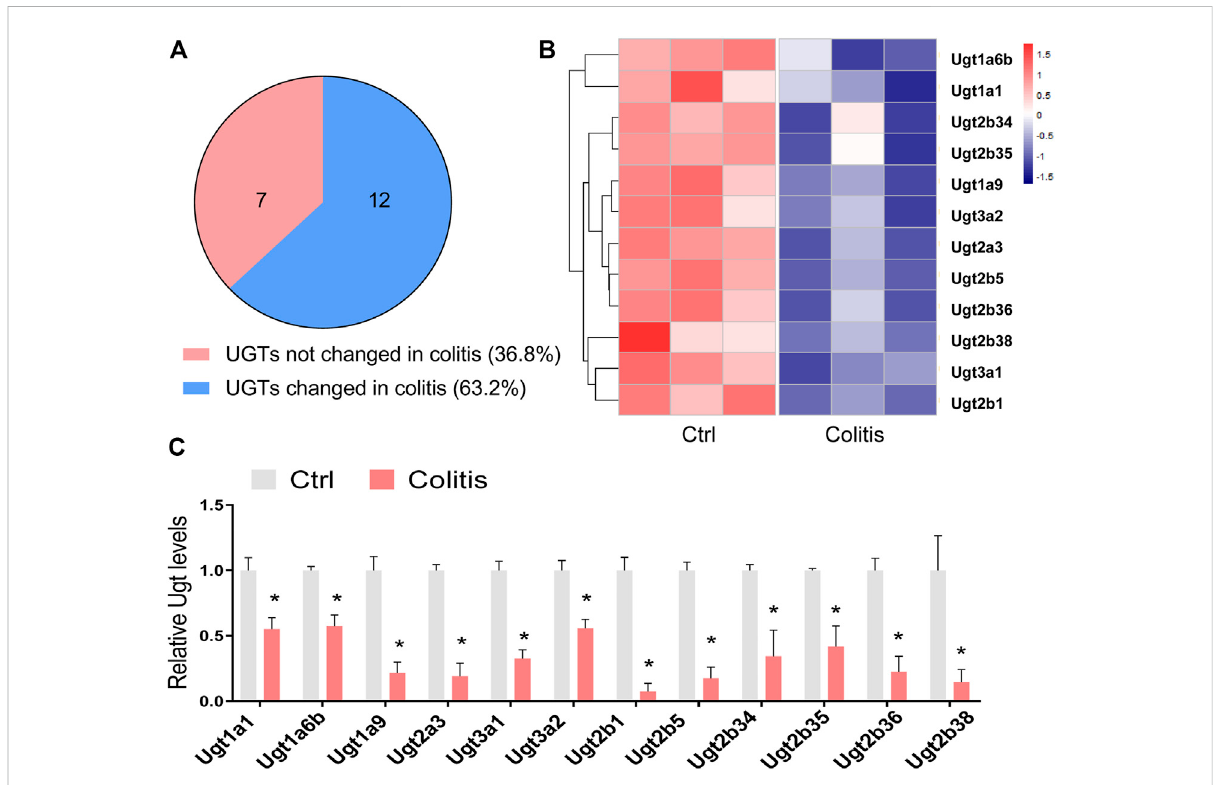
FIGURE 1 Disruption of hepatic UGTs in mice with experimental colitis. (A) Venn diagram shows 12 of 19 UGTs are differentially expressed in colitis. (B) Heatmap showing differentially expressed UGTs in the liver of colitis and control (ctrl) mice. (C) mRNA expression of differentially expressed UGTs in the liver of colitis and control mice. * p <